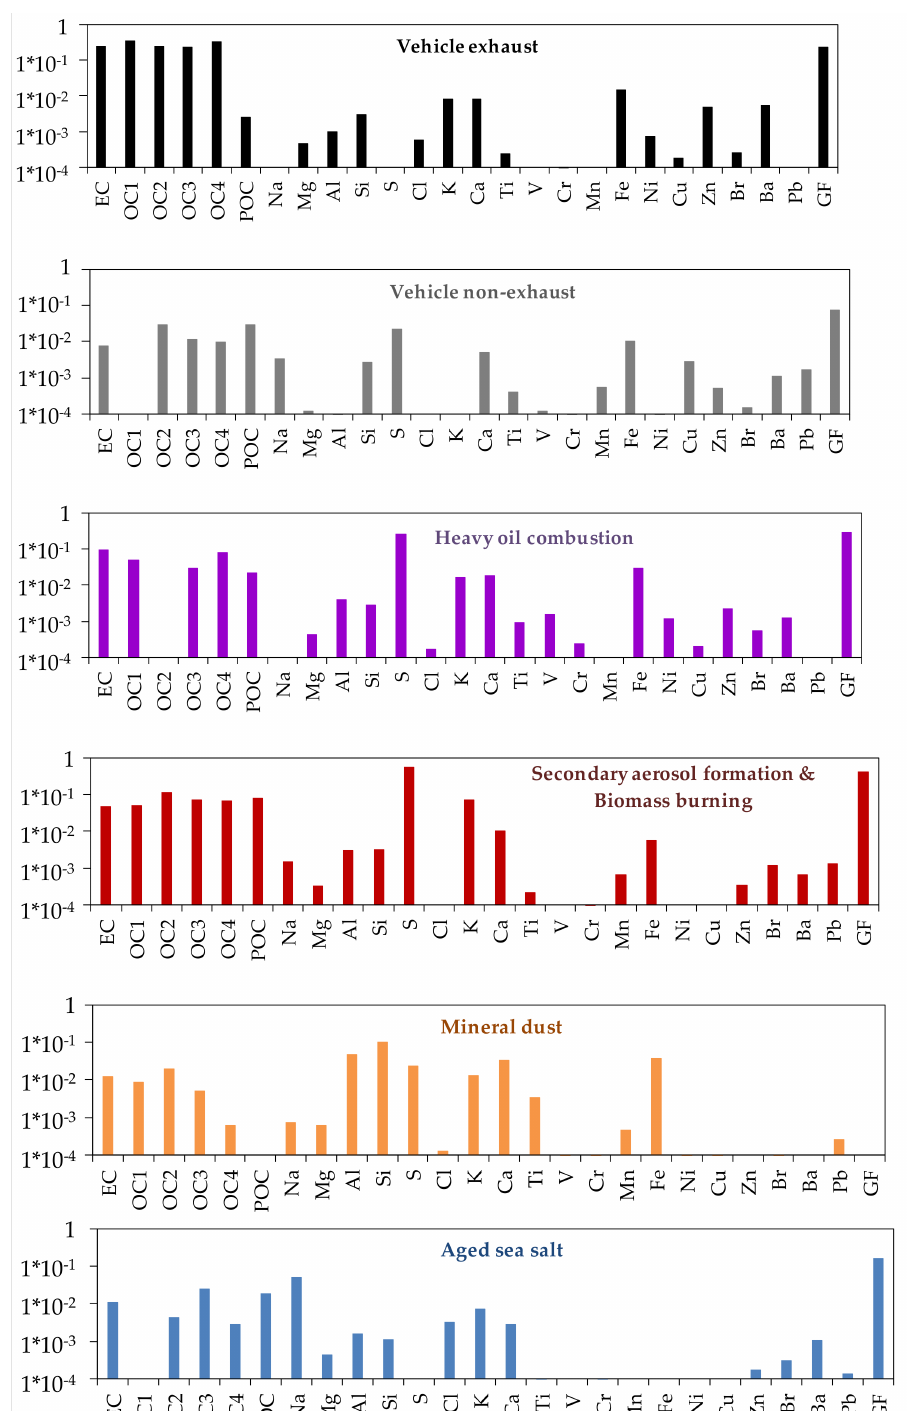
Figure 2. PM 2.5 source profiles identified by applying PMF to the combined chemical composition and hygroscopicity data set. Chemical components’ values relate to relative mass, while GF values relate to the amount apportioned to each source by the